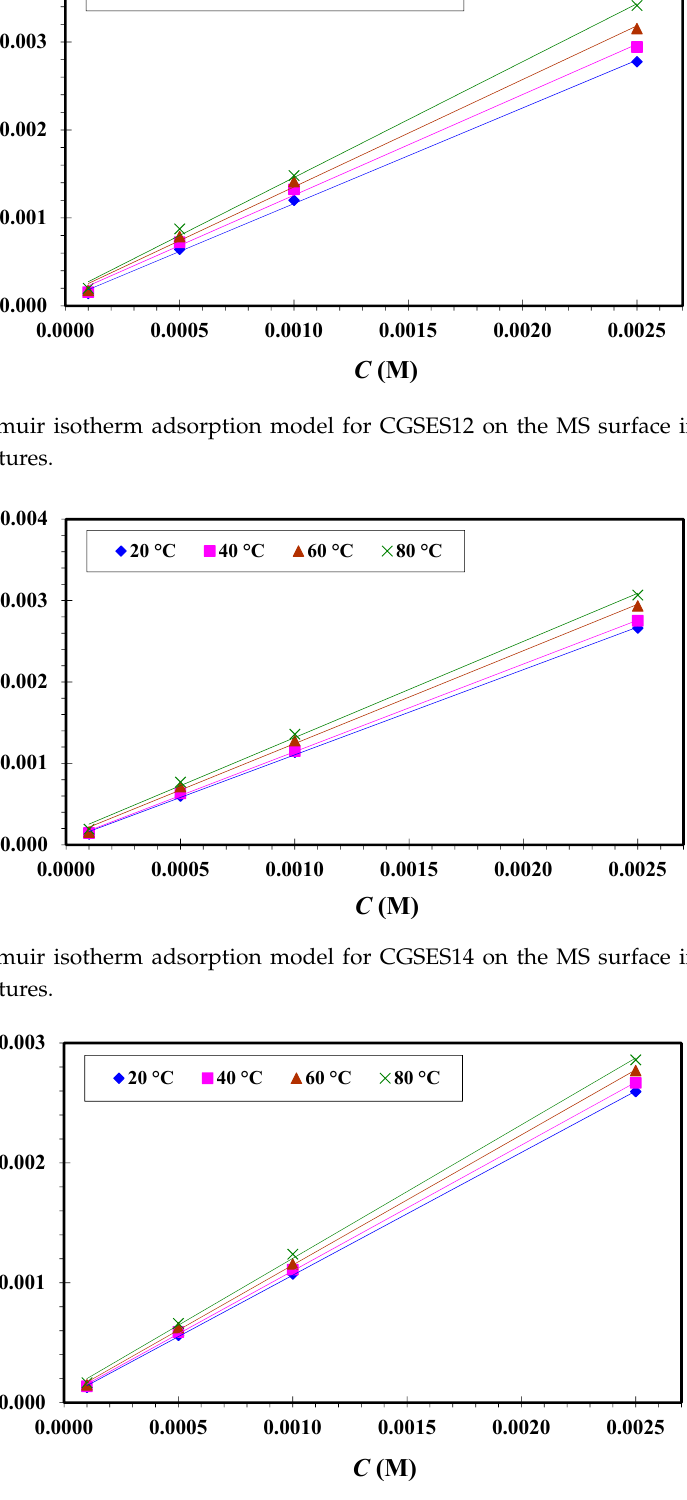
Figure 18. Langmuir isotherm adsorption model for CGSES14 on the carbon steel surface in 1 M HCl at different temperatures.